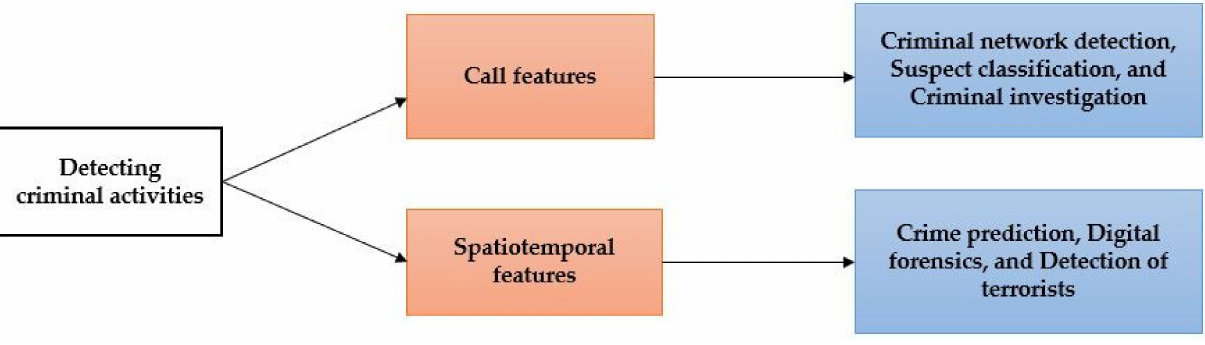
Figure 1. General concept of criminal activity